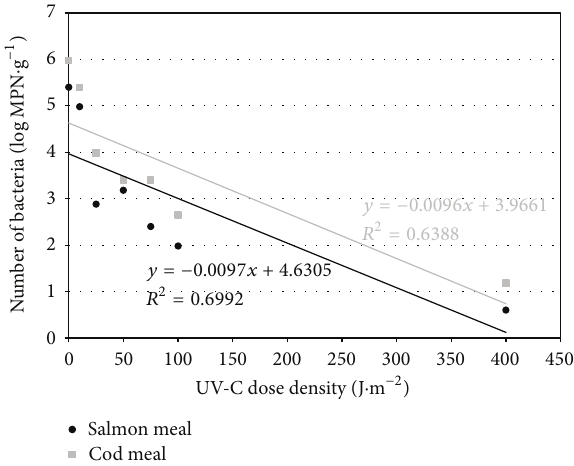
Figure 2: Regression lines describing inactivation kinetics of E. coli .